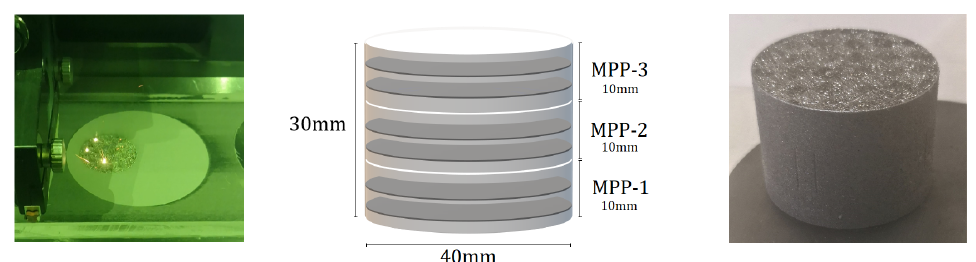
Figure 5. 3D metal printing ( left ); 3D sketch of the cylinder ( center ) and real photograph ( right ) of the cylinder. Two equal samples for three different kinds of specimen were obtained from the cylinder.